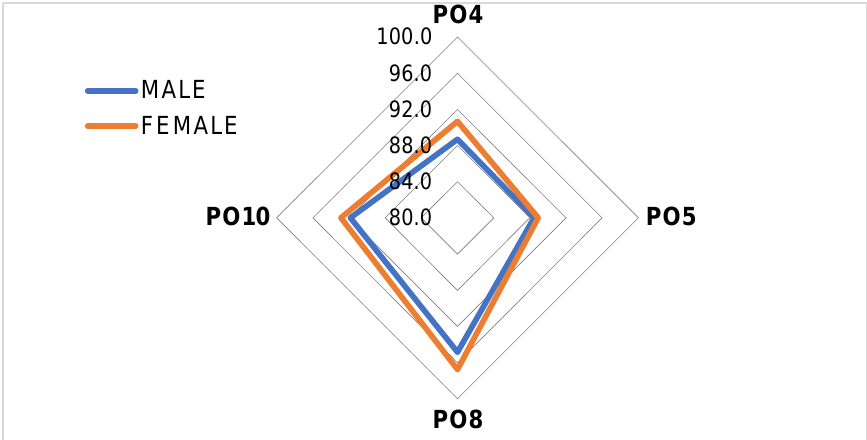
Fig. 5. Comparison of female and male students of the average marks’ attainment for